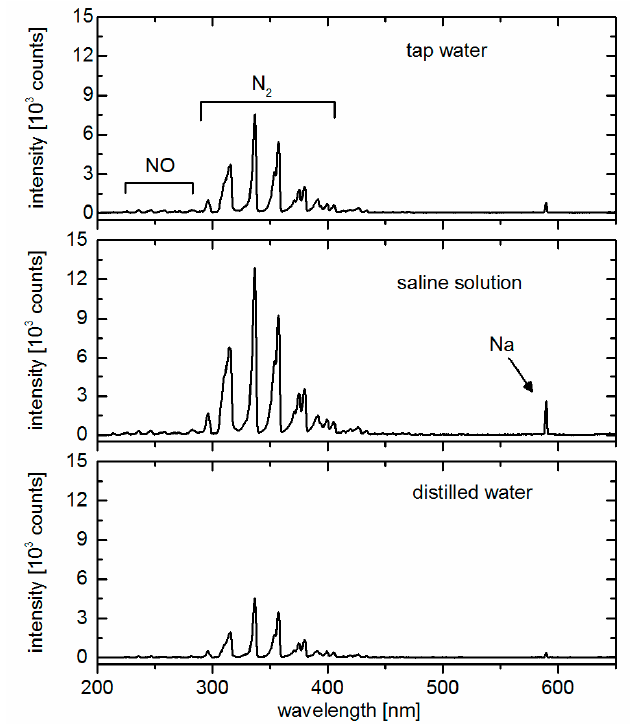
Figure 5. Optical characterization of the discharge for different liquids, the Na-D line is almost missing for liquids not containing sodium.